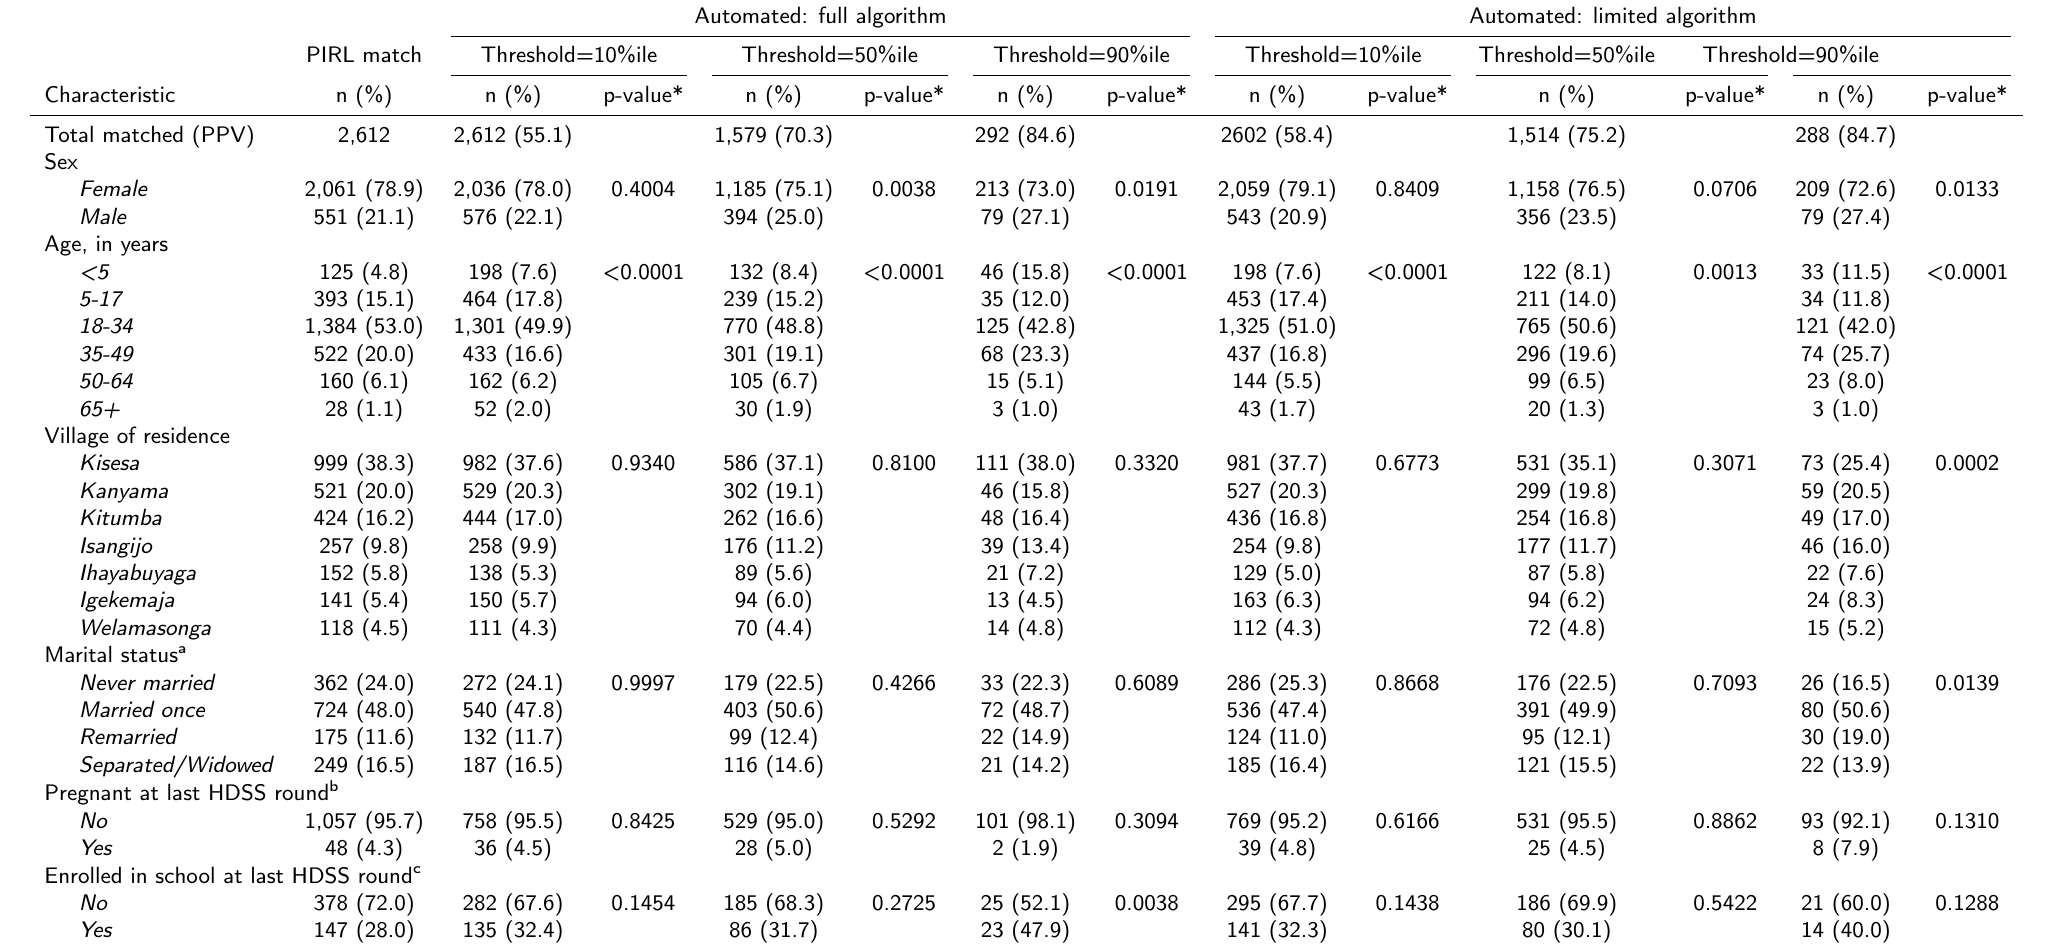
Supplemental Table 2: Distribution of individual characteristics in the dataset matched using point-of-contact interactive record linkage (PIRL) compared with those matched using a purely automated probabilistic approach using a full and limited algorithm, by match score